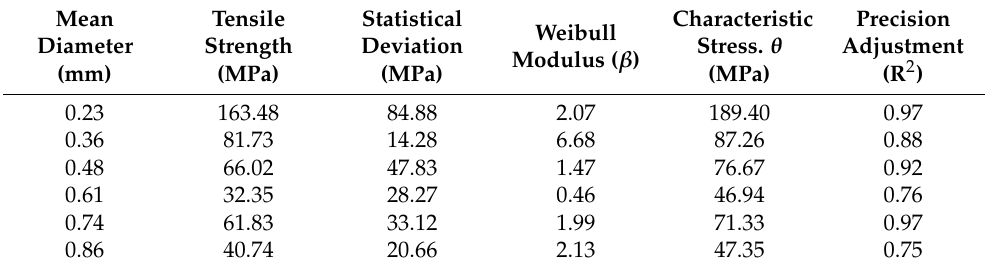
Table 1. Weibull parameters for tensile strength of sedge fibers associated with different mean